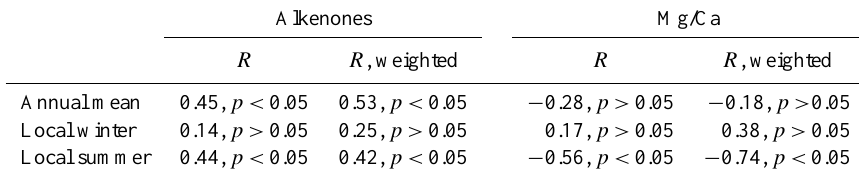
Table 3. List of the correlation between modelled and reconstructed trends (weighted and